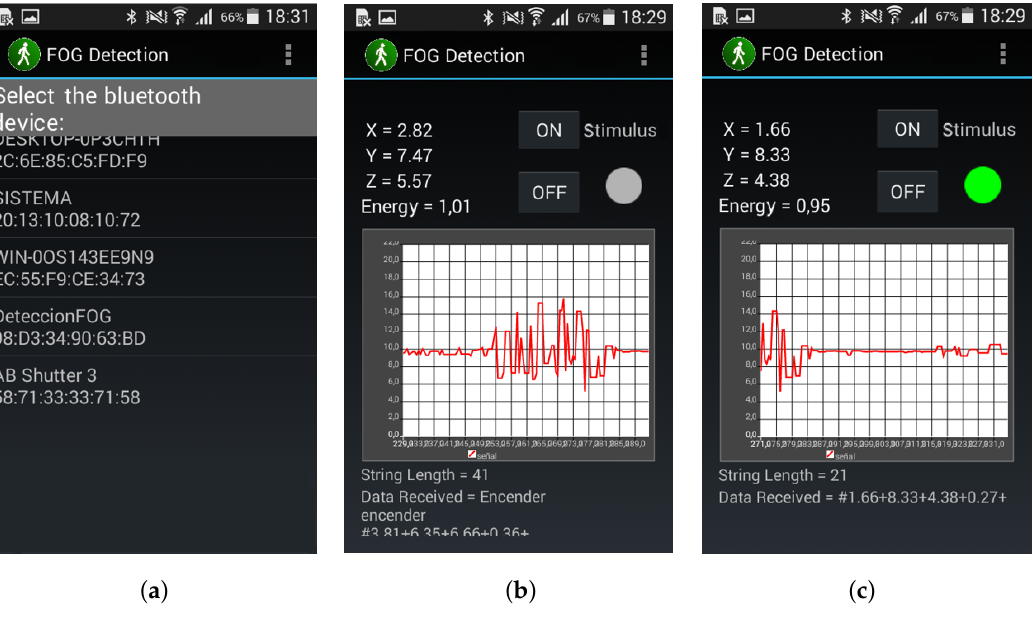
Figure 5. Graphical interface of application “FOG Detection” ( a ) home screen; ( b ) results screen/stimulus OFF; ( c ) results screen/stimulus